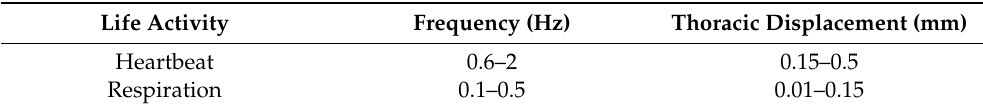
Table 1. Characteristics of respiratory and heartbeat